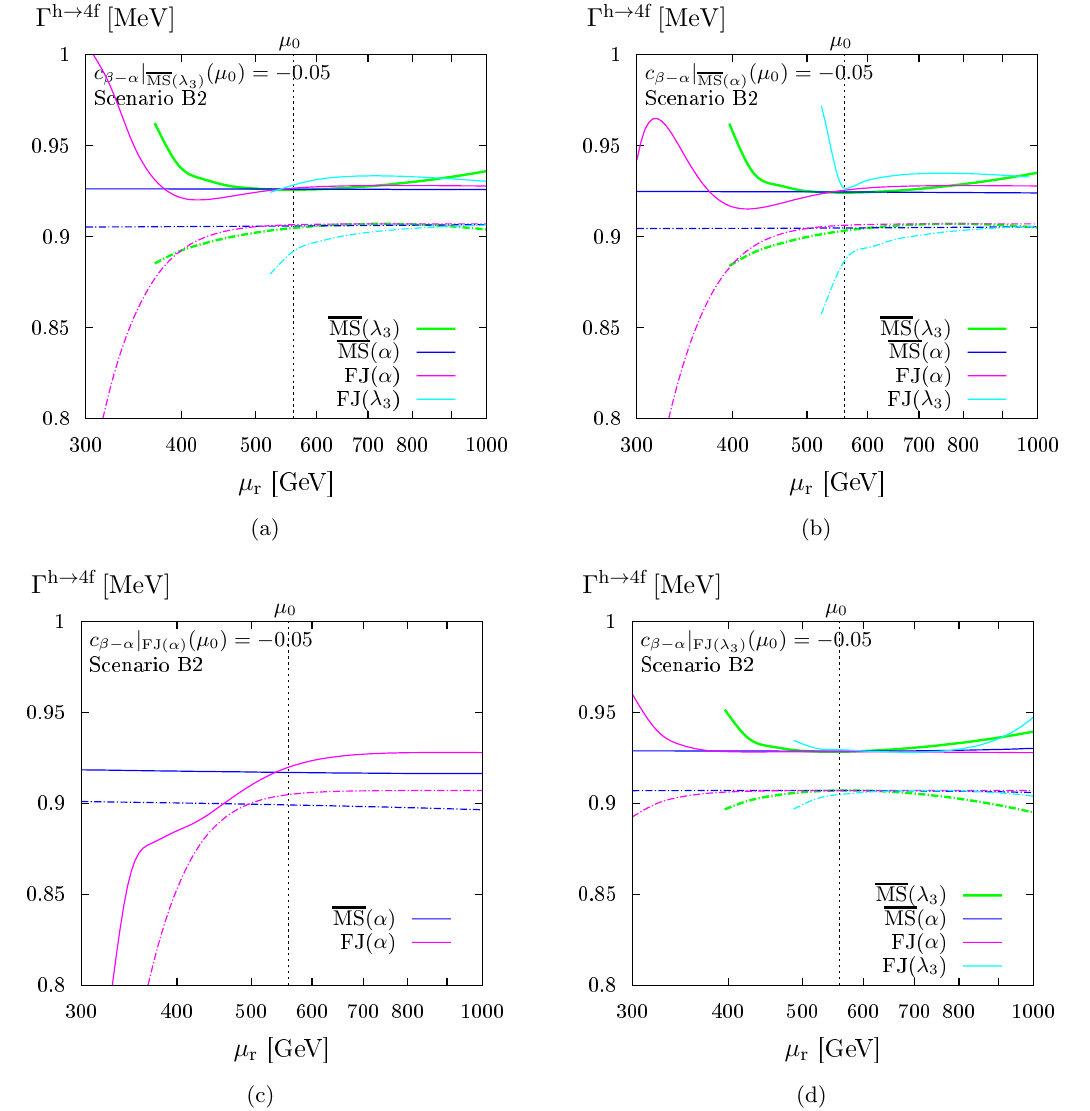
Figure 35 . As in (cid:12)gure 29, but for scenario B2 with c (cid:12) (cid:0) (cid:11) =